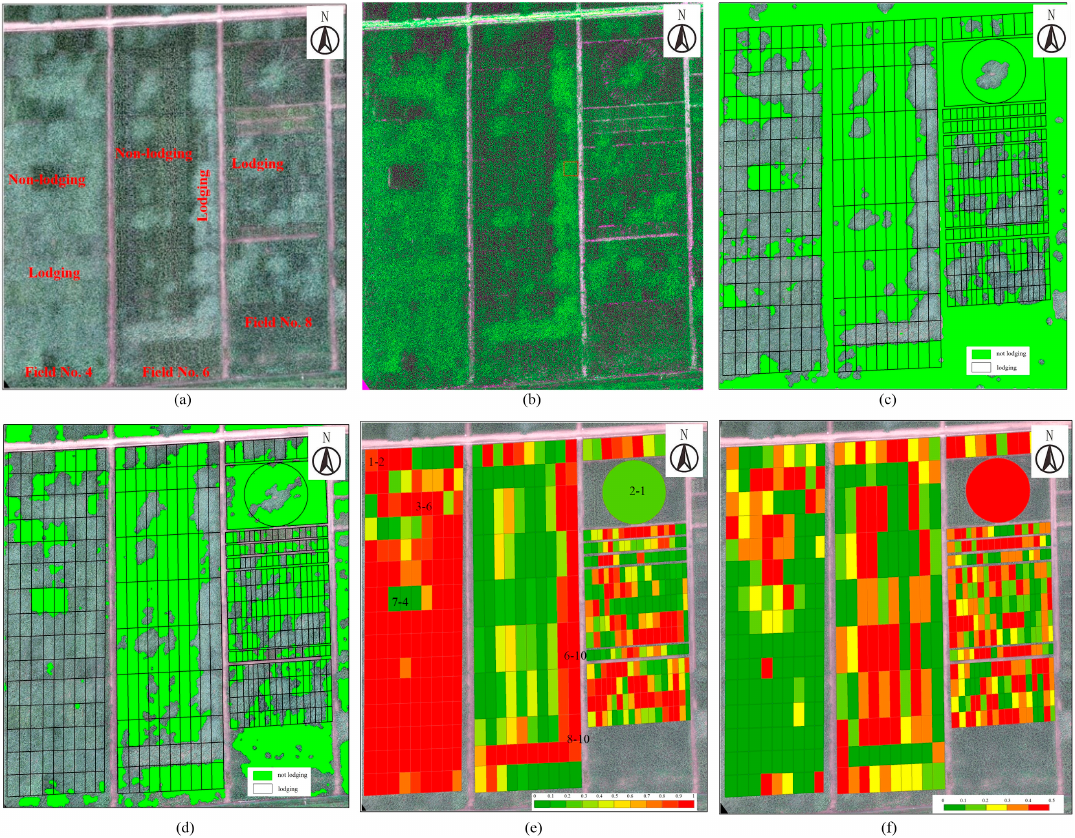
Figure 7. Identification of lodging areas based on texture analysis and the nDSM. ( a ) A preprocessed RGB UAV image; ( b ) the spatial distribution based on the ASM texture feature; ( c ) the estimated lodging area based on the ASM texture feature; ( d ) the estimated lodging area using the nDSM; ( e ) the proportion of the lodging area in every plot; and ( f ) the coefficient of variation (CV) of the lodging area in every plot. Table 3. The measured and estimated lodging areas and the resulting estimation errors using the nDSM method and the ASM textural